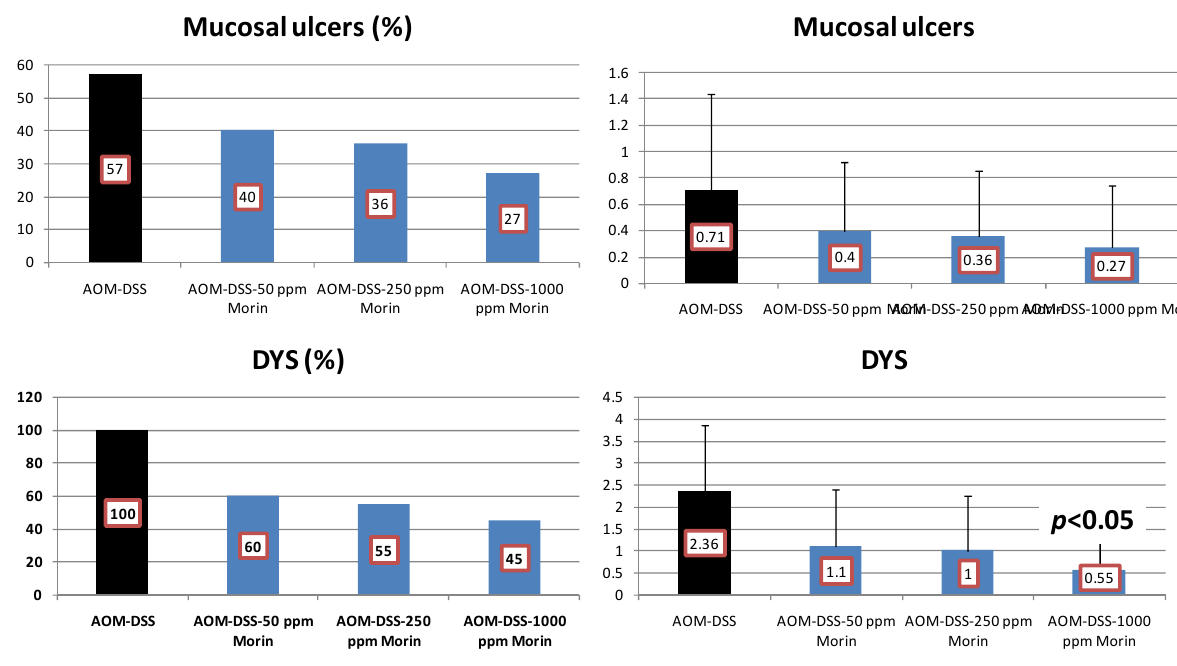
Figure 3. Incidences and multiplicities of mucosal ulcer and dysplastic crypts in the morin study.